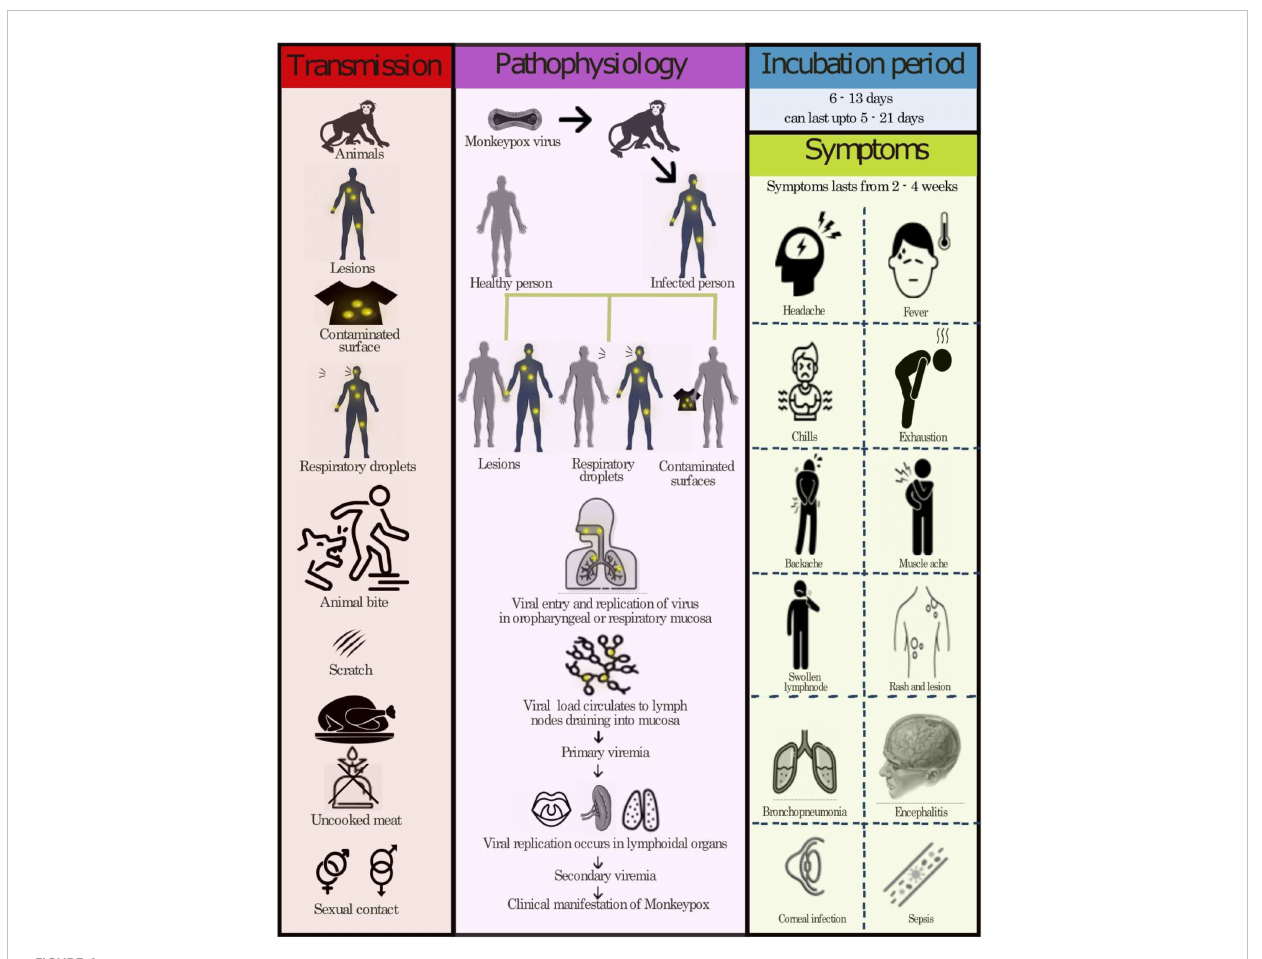
FIGURE 4 Transmission, pathophysiology and symptoms of